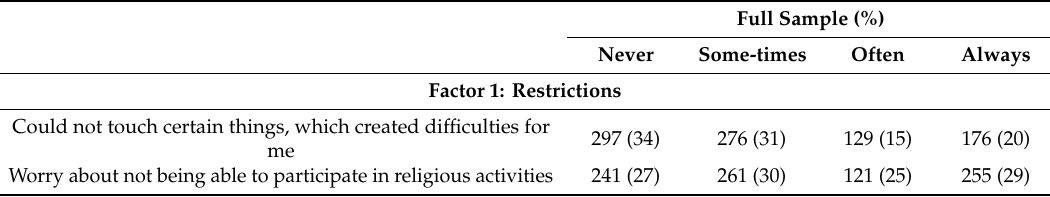
Table 2. Responses frequencies for all Menstrual Insecurity items among women in rural Orissa, India, organized by factor analysis results and including deleted items (n =